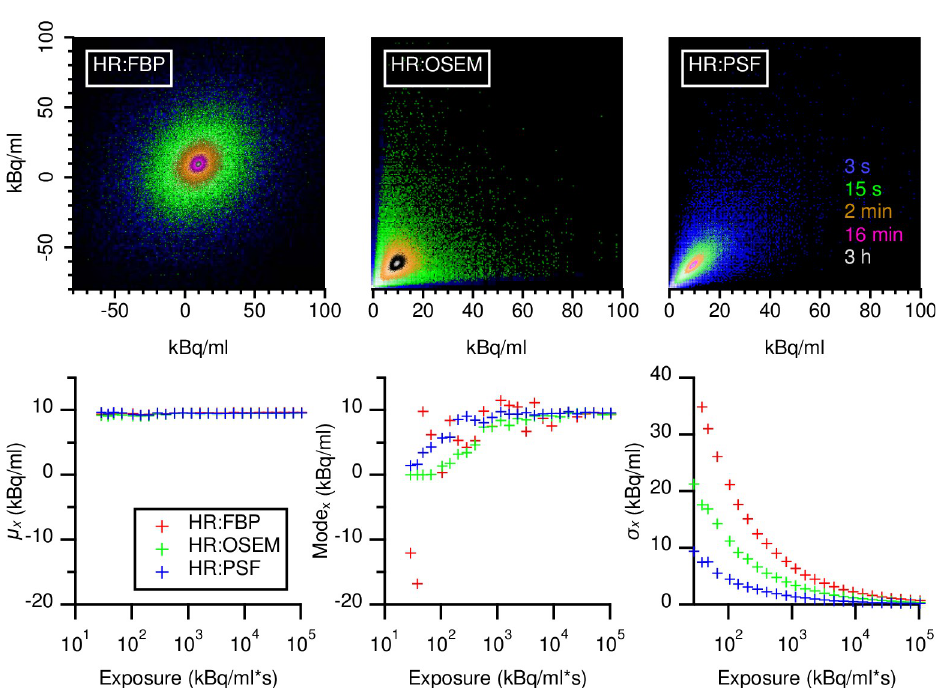
Fig 3. Overlaid examples of 8 bit GLCMs in units of kBq/ml. GLCMs calculated from HR datasets and reconstructed with either with FBP, OSEM, or TrueX, PSF. Five selected acquisition durations are shown at their location in respect to absolute activity concentrations. For visualization (top). GLCM maxima are normalized to unity and are displayed with a logarithmic color scale. Acquisition times are noted besides the PSF GLCM in the respective color.